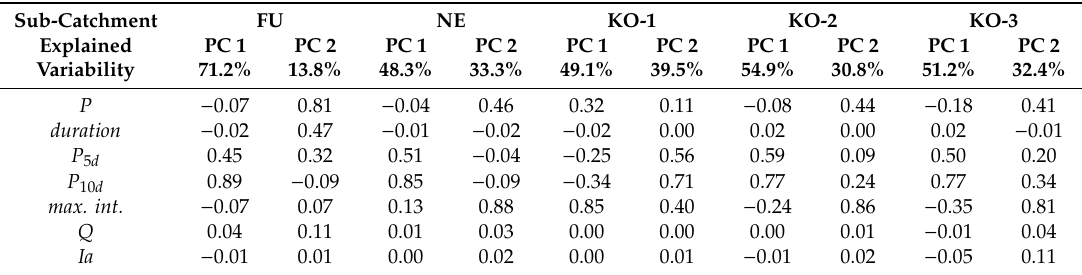
Table 4. Quantitative outputs of the principal component analysis (PCA) for each study catchment: Percentage of variability explained by PC1 and PC2 along with the loading values for each input parameter.